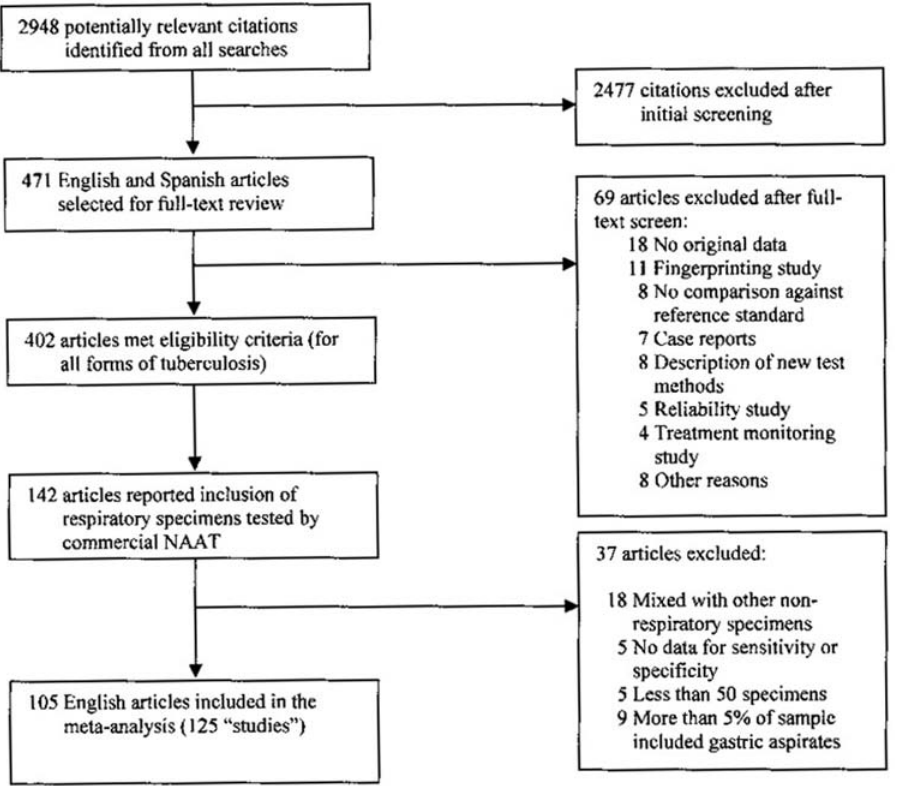
Figure 1. Study selection process.